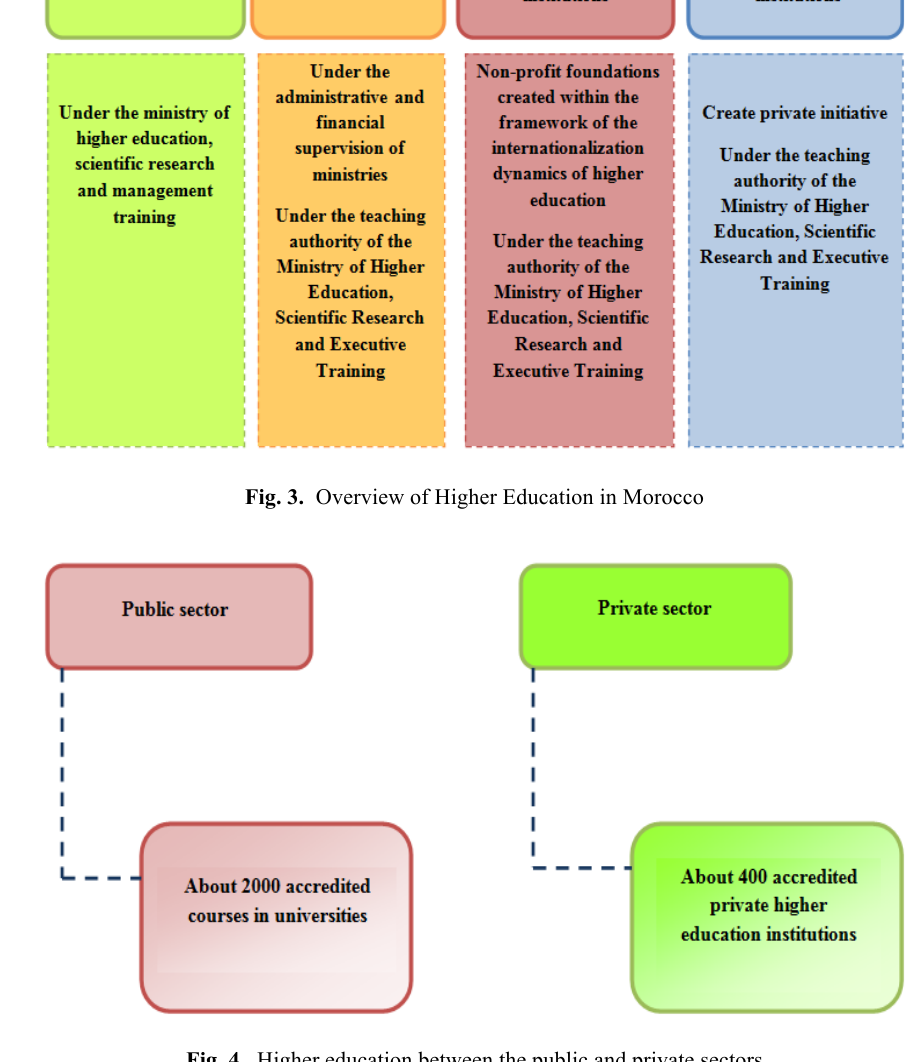
Fig. 4. Higher education between the public and private